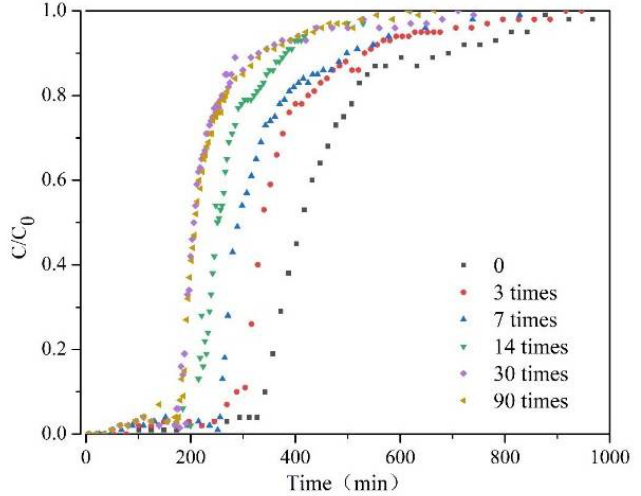
Figure 9. Breakthrough curves of Br − 1 of S/S lead-zinc-cadmium composite HM-contaminated soil subjected to six kinds of F-T cycles: (1) 0, (2) 3, (3) 7, (4) 14, (5) 30, and (6) 90 times.